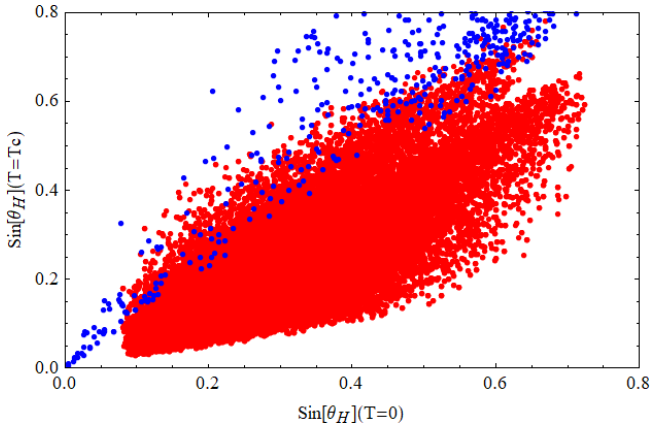
Figure 12 . The sin (cid:18) H as T = T C and T = 0 for one-step and two-step SFOEWPT. Open